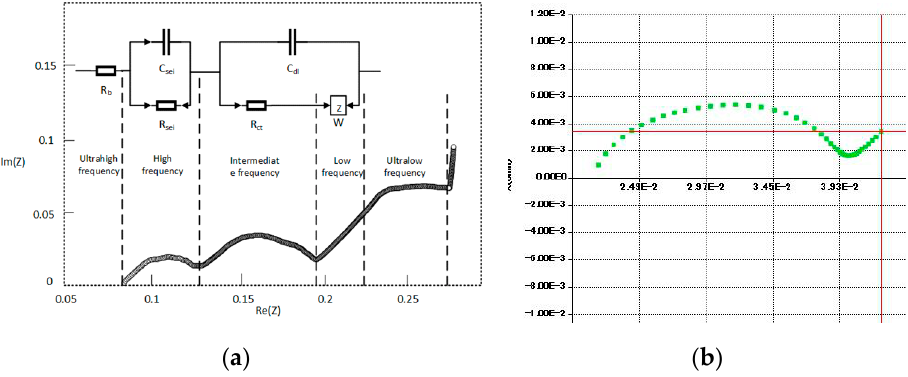
Figure 2. Electrochemical impedance spectroscopy (EIS) of lithium-ion battery: ( a ) EIS and equivalent circle model of Li-ion battery; ( b ) EIS in intermediate frequency (IF) part of one 18,650 cell using BT4560.